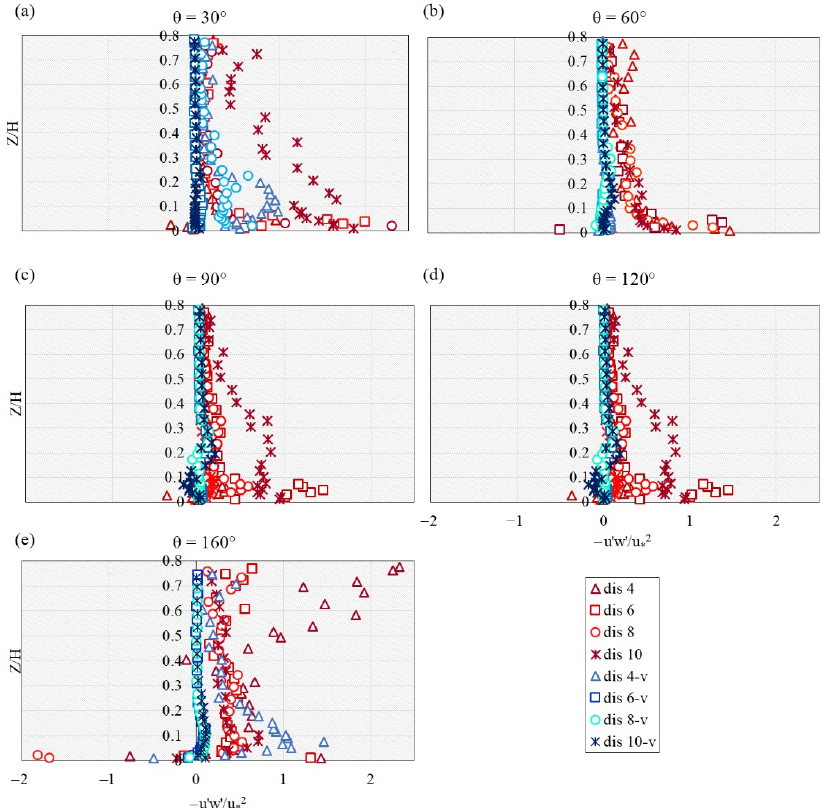
Figure 16. Comparison of the Reynolds shear stress distribution at the azimuthal planes with specific distances from the abutment surface (4, 6, 8, and 10 cm) for the case without vegetation in the bed (marked by red symbols) and with vegetation in the bed (marked by blue symbols).